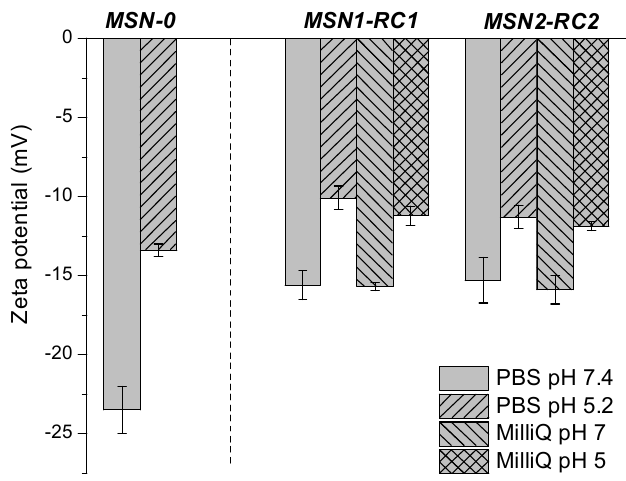
Figure 6. Zeta potential of the bare nanomaterial MSN-0 and of final ruthenium-functionalized nanomaterials MSN1-RC1 and MSN2-RC2 in both media MilliQ water and / or PBS at pH 7.4 and 5.2.